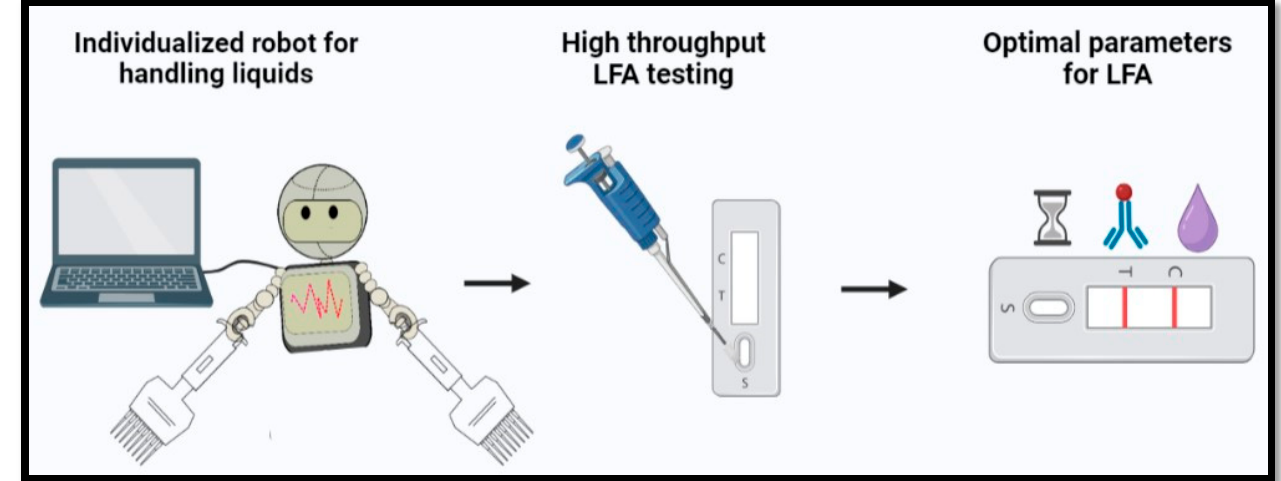
Figure 2. Diagrammatic representation of robotic-based LFA: Individualized Robot for handling liquids; High throughput Lateral Flow Assay Testing; Optimal parameters for Lateral Flow Assay, i.e., different time response, selections of bioreceptors selections, and targeting of different bodily fl uids.